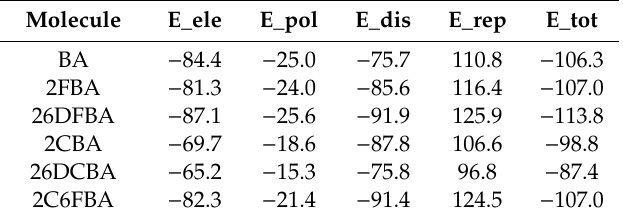
Table 10. CE-B3LYP intreraction energies partition results for the crystals of the studied compounds a .